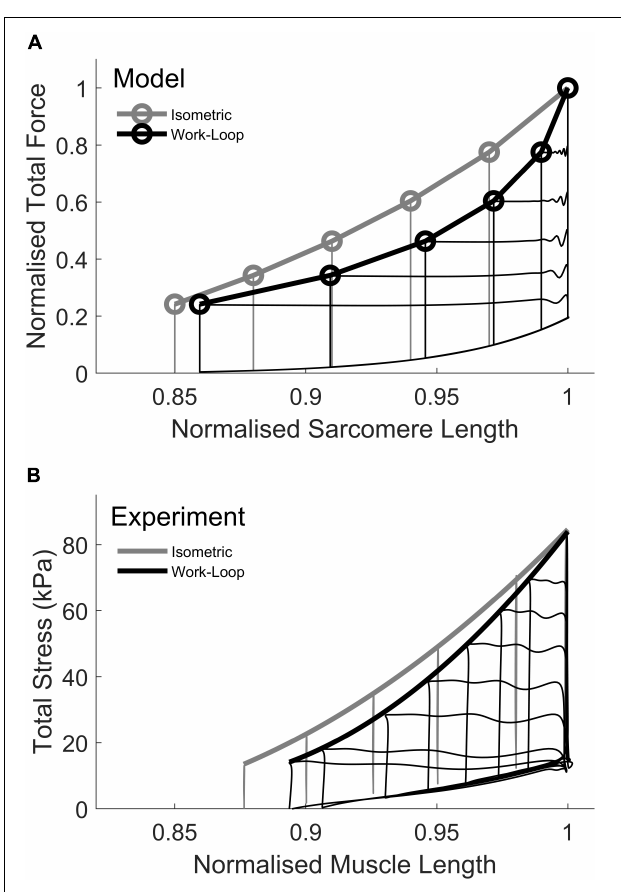
FIGURE 3 | Simulation of isometric and work-loop end-systolic force-length relations (ESFLR). (A) The isometric ESFLR (gray) was simulated from six isometric contractions at sarcomere lengths ranging from 1.95 to 2.3 µ m (L o ). Sarcomere lengths were normalized to L o . The work-loop ESFLR was simulated from five work-loop contractions commencing at an initial sarcomere length of L o . Each work-loop contraction is matched by an isometric contraction of equivalent force. Note that the work-loop contraction at the highest afterload is identical to the L o -isometric contraction. (B) Experimental data depicting the isometric ESFLR and work-loop ESLFR from left ventricular rat trabeculae. Reproduced from data reported in Tran et al. (2016).